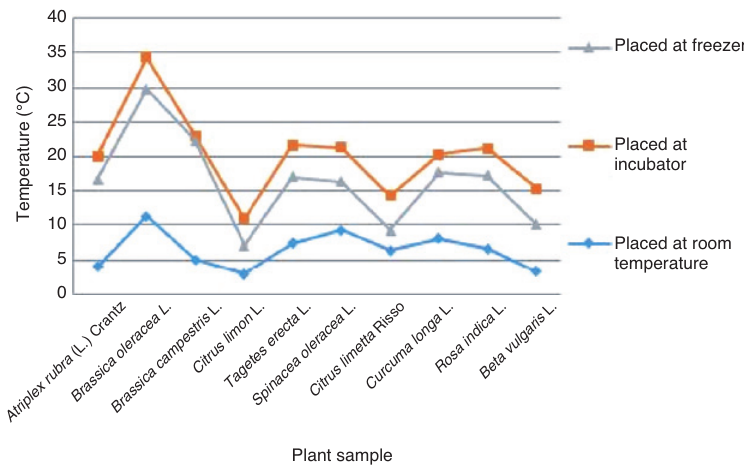
Figure 4: Stability of extracts at various